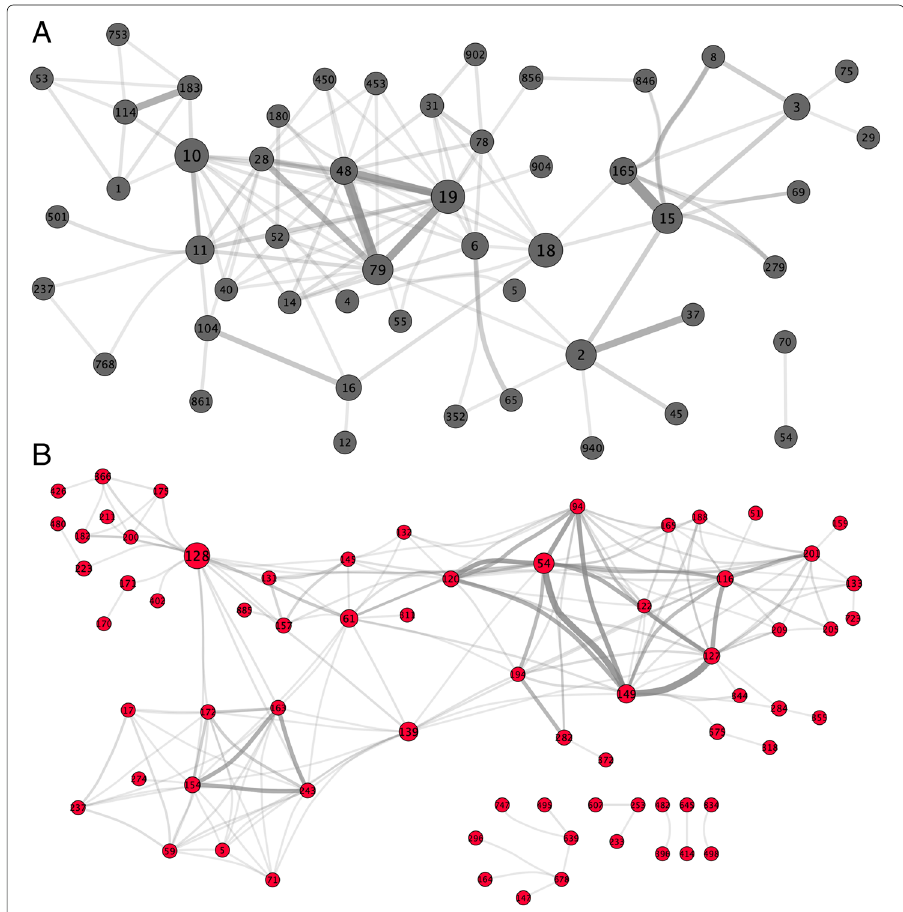
Fig. 8 Projection of breast cancer modules linked by shared enriched GO terms. a Control projection. b Tumor projection. Modules which show enrichment, but are not connected to other through